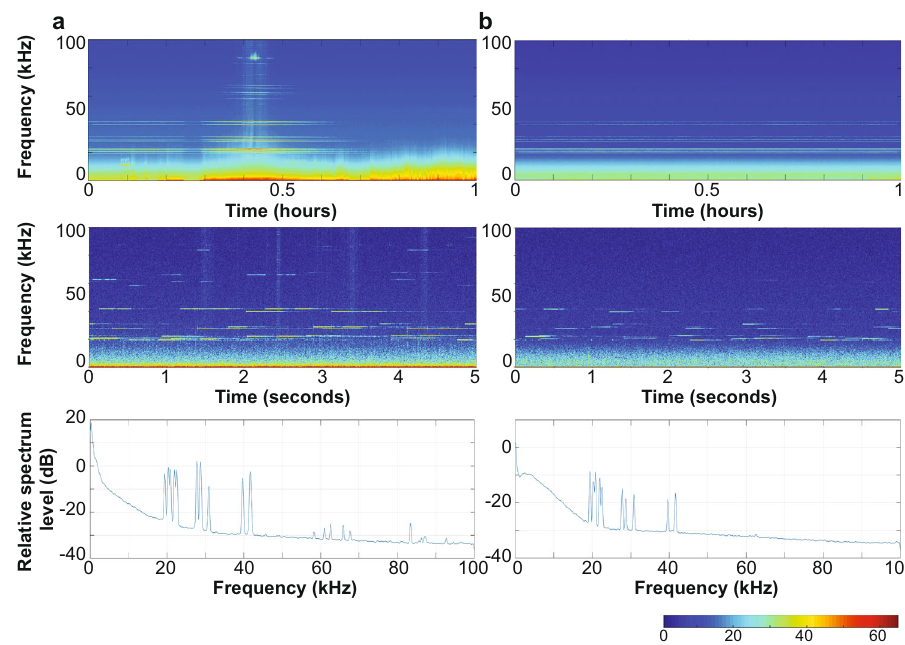
Fig. 2 Ultrasonic antifouling signal. Long-term spectral average (top), spectrogram (middle), and spectrum (bottom) recorded on the sea fl oor-mounted acoustic recorder within Bahía Norte of tourist boats equipped with UA systems a transiting over the recorder and b anchored near the coastline ~2 km away. A shipboard echosounder operating at 88 kHz by the transiting boat is also present in a